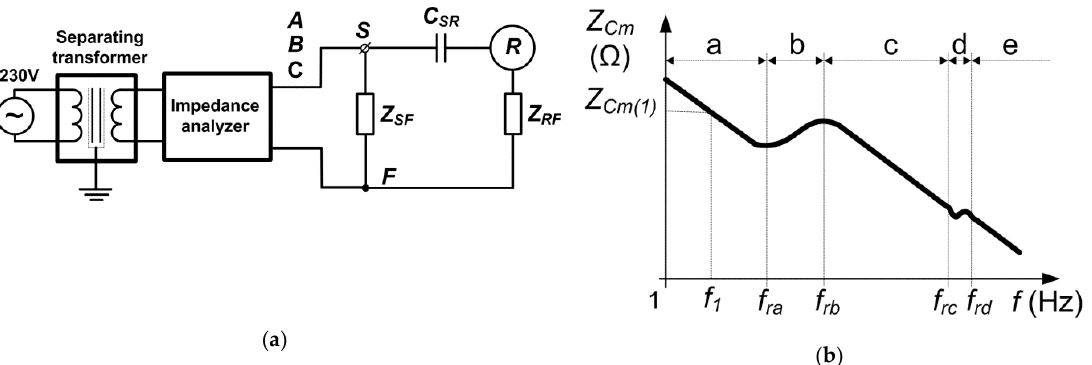
Figure 7. Measurement of IM common-mode impedance Z Cm : ( a ) measurement setup; ( b ) Z Cm ( ω ) characteristic.